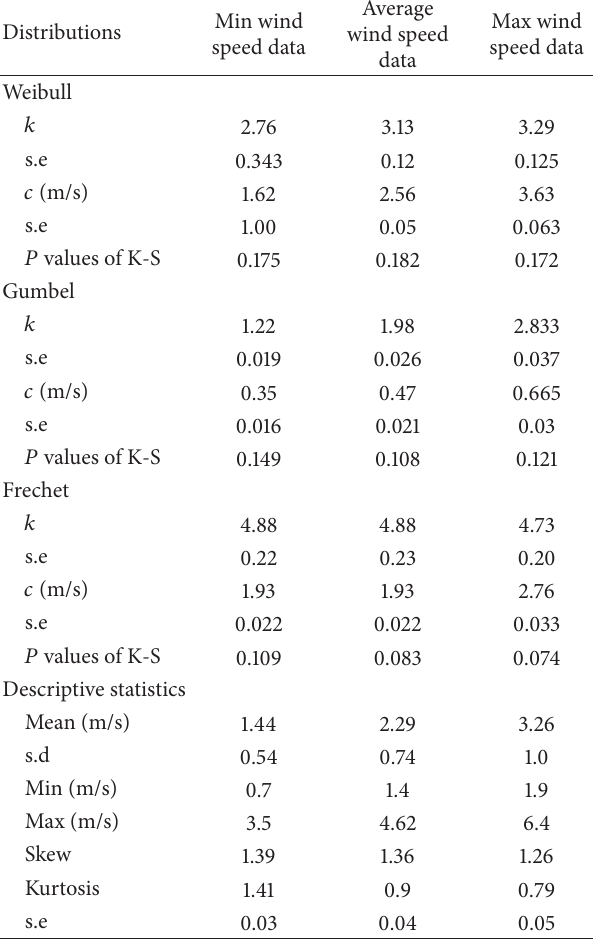
Table 1: Data summary statistics and parameter estimates.